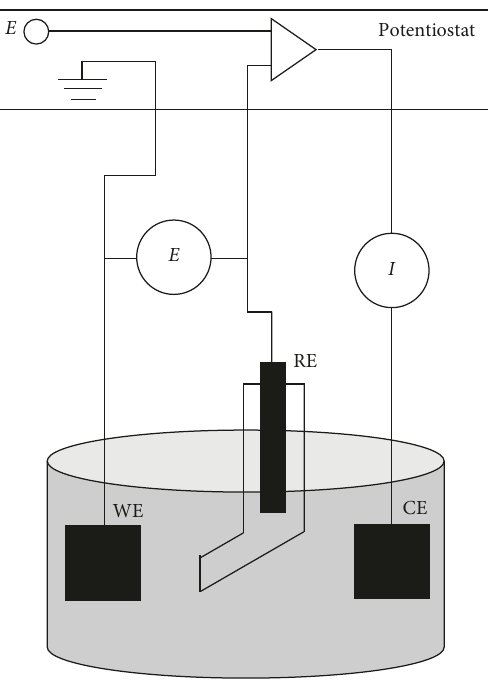
Figure 1: The series of equipment for potentiostatic polarization method (working electrode is carbon steel, reference electrode is Hg 2 Cl 2 , and counter electrode is platinum).